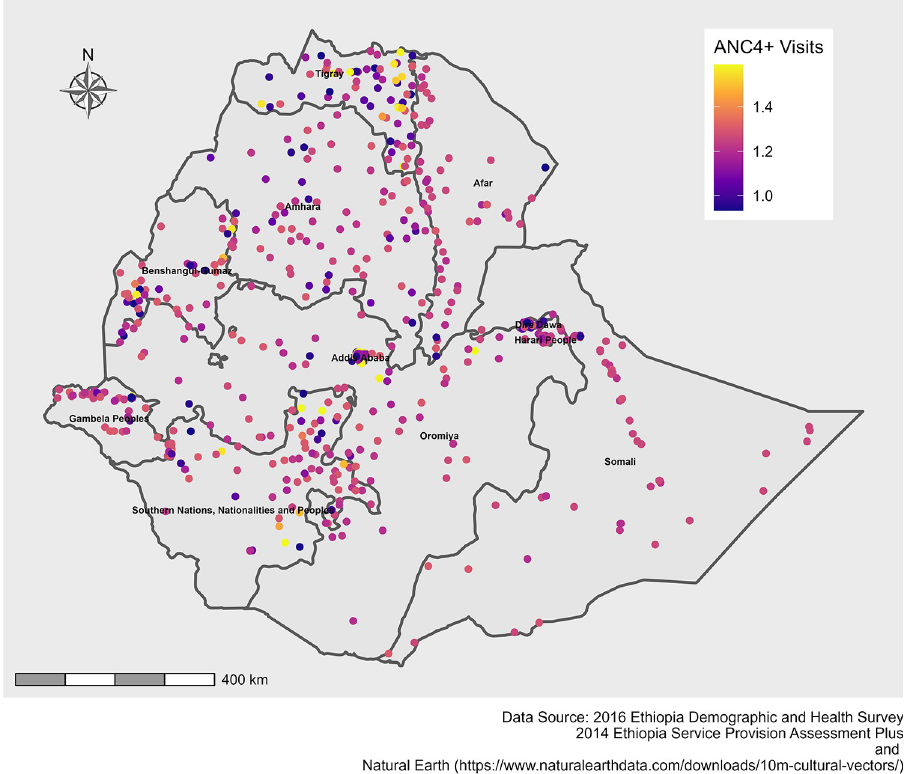
Fig 5. Spatial variations of caesarean delivery use with spatially varying coefficients of � 4 ANC visits in Ethiopia, 2016.